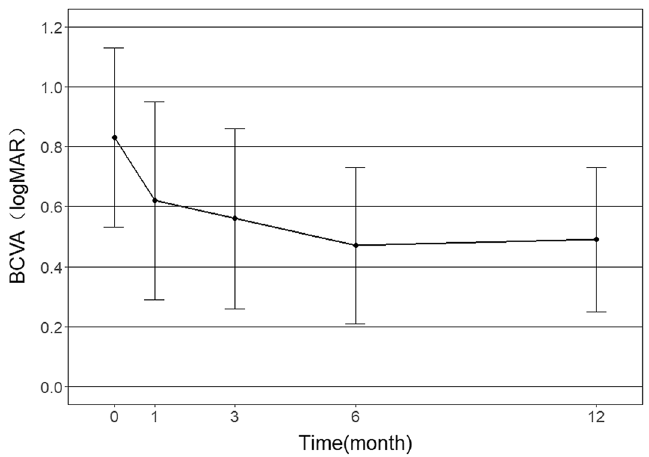
Figure 1. Visual acuity of mCNV eyes in patients over 50 years treated by Conbercept during one-year follow-up (N = 21).